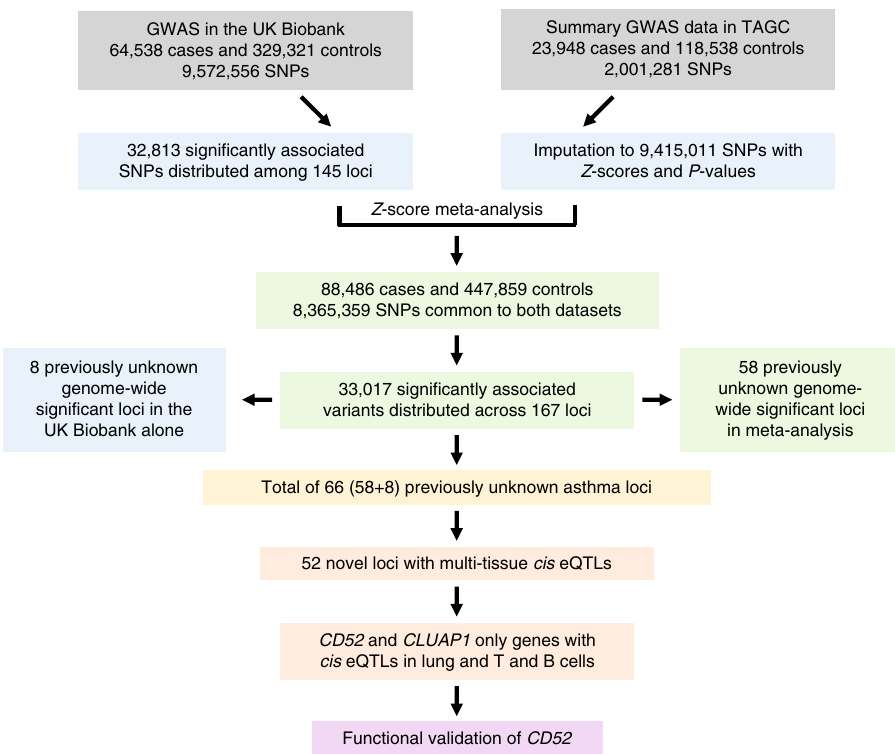
Fig. 1 Overview of genetic and functional analyses. A GWAS was fi rst carried out using primary level data in the UK Biobank with ~9.5 million SNPs. In parallel, summary statistics were imputed based on publicly available GWAS data from the TAGC. The results were combined in a Z-score meta-analysis that included 88,486 asthma cases and 447,859 controls with 8,365,359 variants common to both datasets. 58 previously unknown genome-wide signi fi cant loci for asthma were identi fi ed in the meta-analysis. Combined with the eight previously unknown genome-wide signi fi cant loci from the GWAS analysis in the UK Biobank alone, a total of 66 previously unknown asthma susceptibility loci were identi fi ed. Follow up bioinformatics and eQTL analyses prioritized CD52 for in vivo functional validation